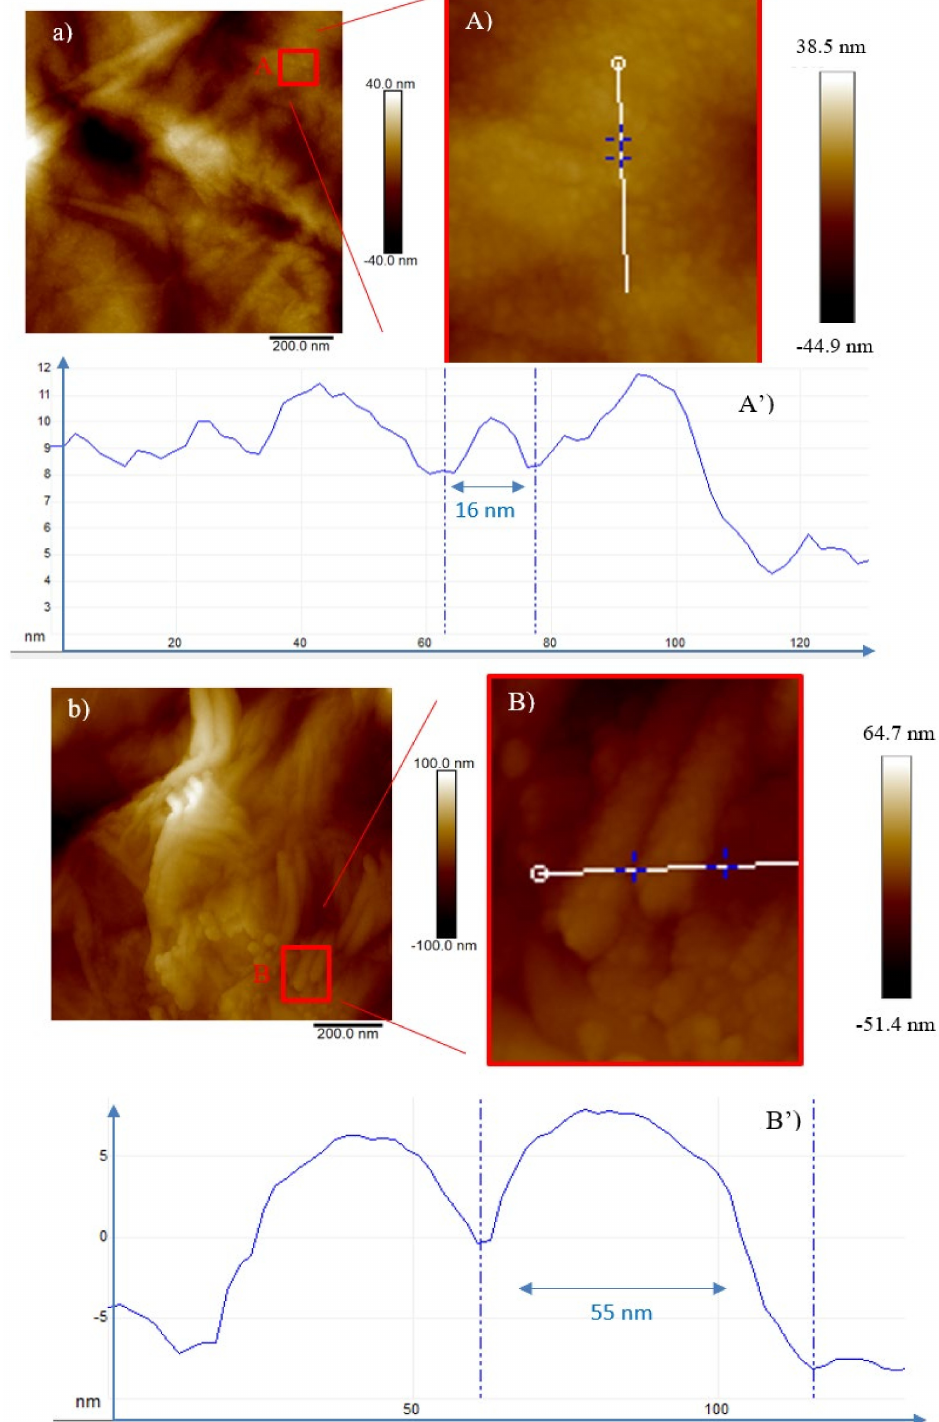
Figure 8. Two-dimensional AFM images of GO irradiated by the 3 MeV O + ions at the 5 × 10 11 ions/cm 2 ( a ), magnified area of the red square ( A ) and profile of the selected structure ( A’ ) and at the 5 × 10 12 ions/cm 2 fluence ( b ), magnified area of the red square ( B ) and profile of the selected structure ( B’